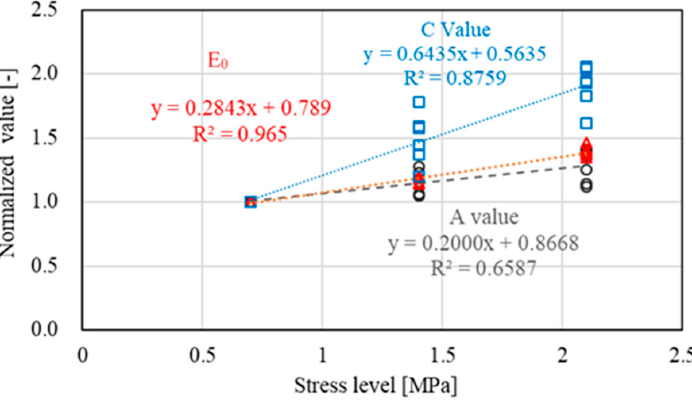
Figure 11. Stress dependence of model parameters based on normalized analysis.